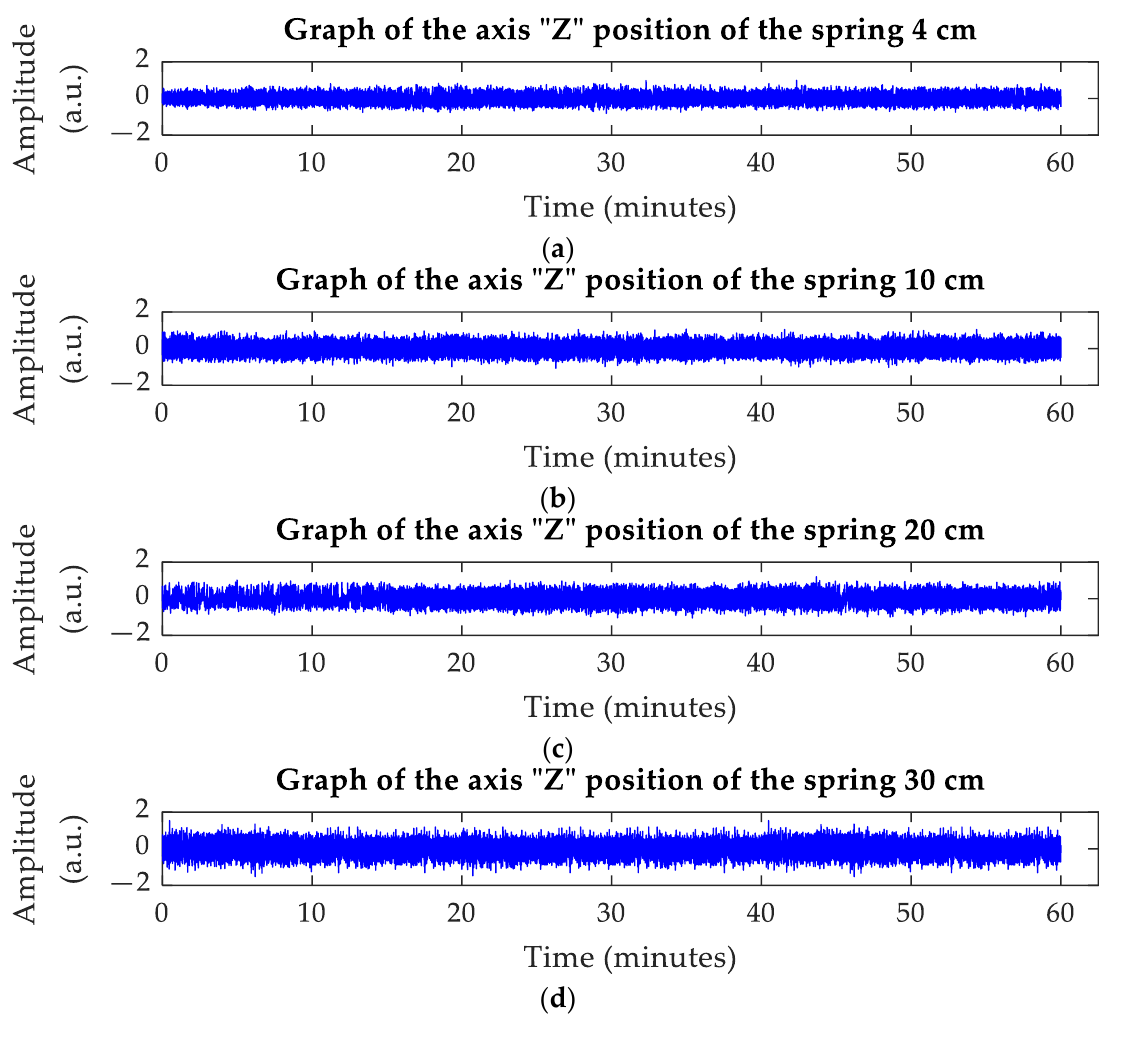
Figure 5. ( a ) ratio between amplitude of the "Z" axis and time in seconds at spring position 4 cm, a.u. (arbitrary units); ( b ) ratio between amplitude of the "Z" axis and time in seconds at spring position 10 cm, a.u (arbitrary units); ( c ) ratio between amplitude of the "Z" axis and time in seconds at spring position 20 cm, a.u. (arbitrary units); ( d ) ratio between amplitude of the "Z" axis and time in seconds at spring position 30 cm, a.u.(arbitrary units).